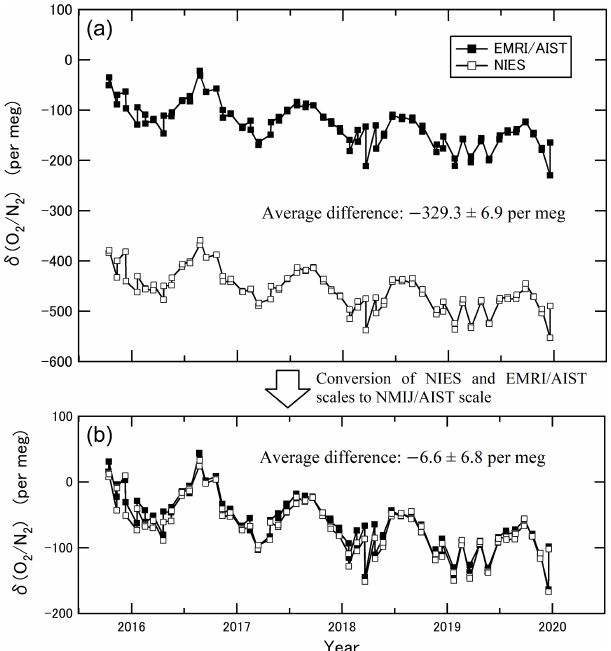
Figure 4. (a) The δ (O 2 / N 2 ) values obtained from the duplicate air samples collected at Hateruma Island for 4 years (2015–2019) measured by EMRI/AIST and NIES. (b) The δ (O 2 / N 2 ) values at Hateruma converted from EMRI/AIST and NIES scales to the NMIJ/AIST scale.